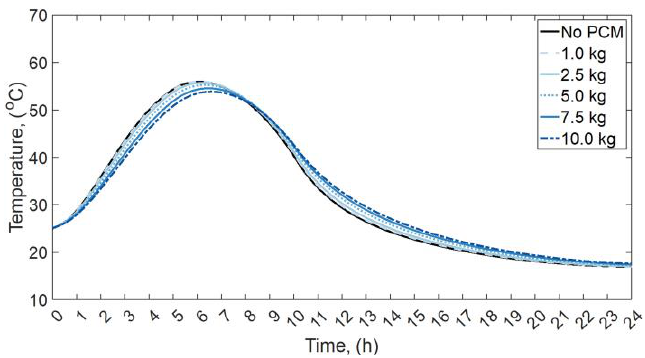
Figure 20. Water temperature in the SS with different masses of PCM — Case 4.